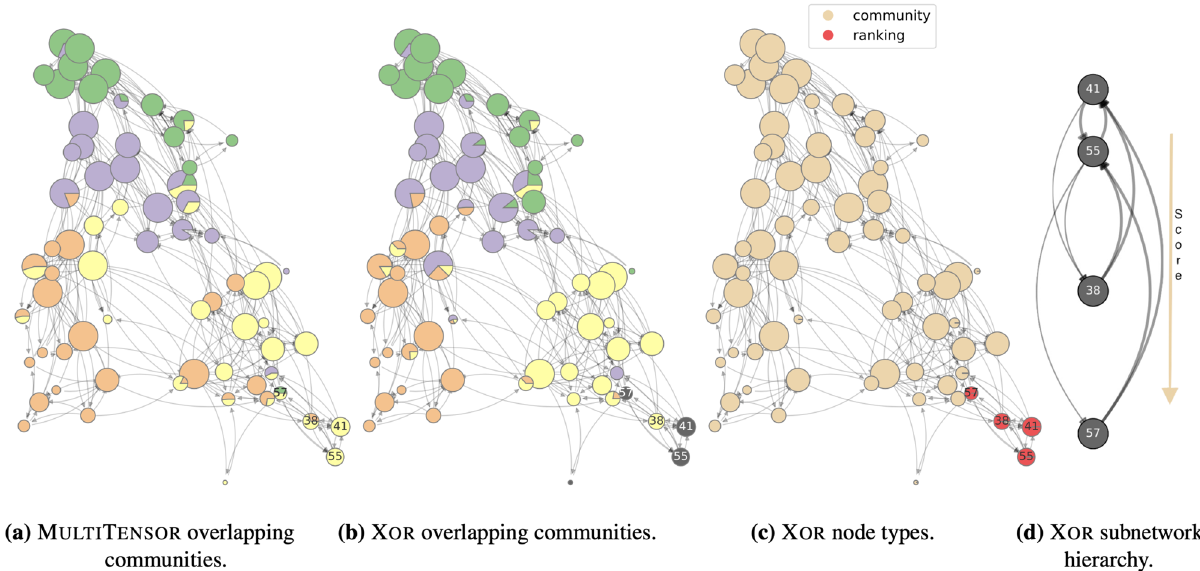
Figure 3. Application on High School network: ( a ), ( b ) comparison between the communities detected by MultiTensor and Xor, ( c ) node types Q visualization and ( d ) hierarchy in the subnetwork of nodes preferring the competitive mechanism. Nodes’ positions are assigned: ( a )–( c ) using a spring layout and ( d ) using the scores s inferred by the Xor algorithm. Communities are selected by normalizing the v membership vector (similar results are obtained with u ) and colors of the pie markers are assigned according to the community (mixed) membership in each group. The dark grey nodes have null membership vector. Both the algorithms select K = 4 as optimal number of communities, as output using a five-fold cross-validation scheme and grid